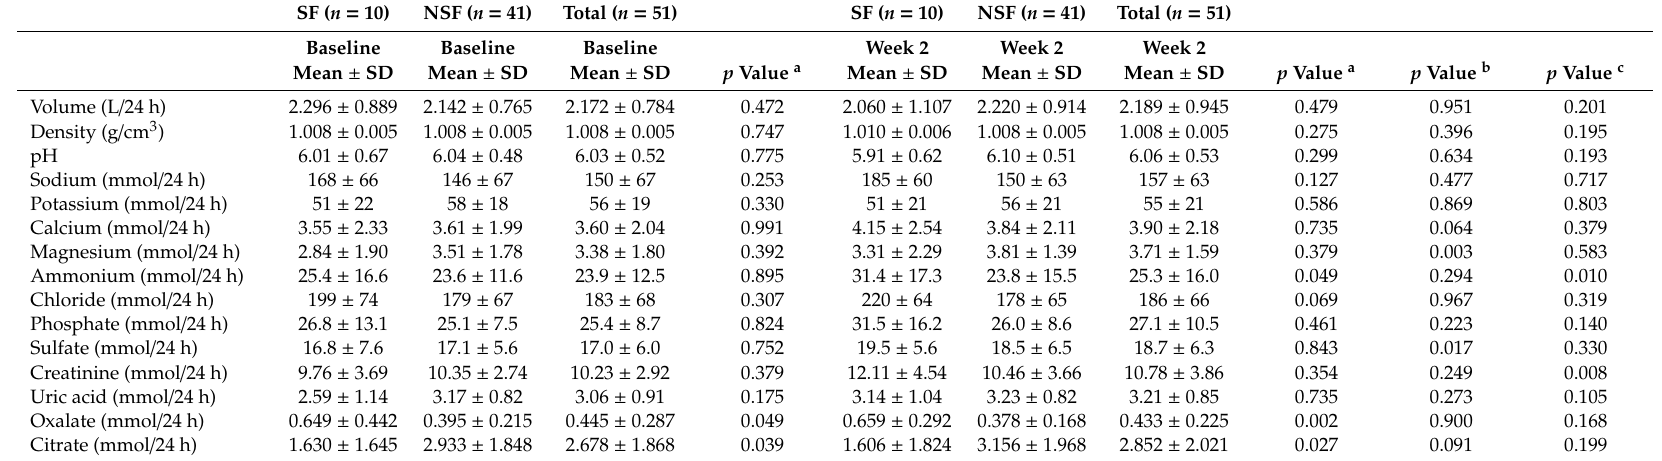
Table 5. Urinary parameters of stone formers and non-stone formers at baseline and after ADEK